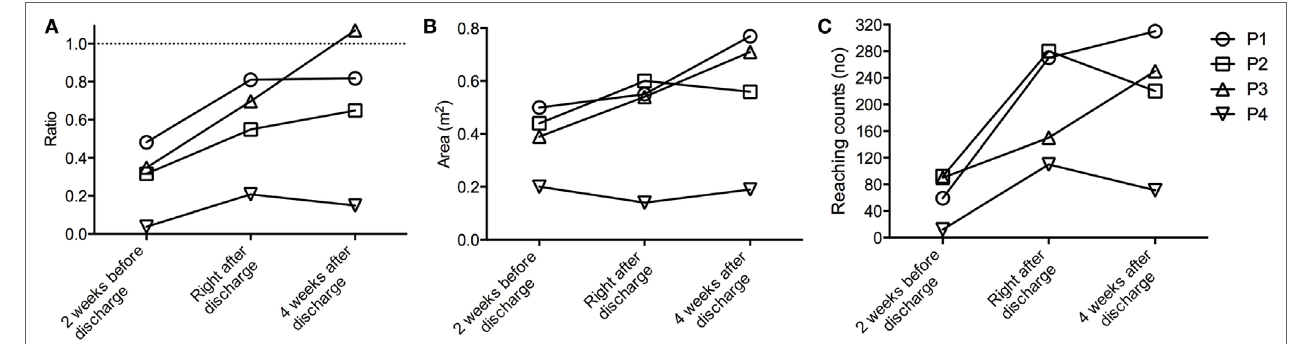
FigUre 3 | Self-directed Activities of Daily Living (sADL). (a) Ratio of reaching counts between non-impaired and the impaired side. (B) Reaching area of the impaired side in the different stages of the rehabilitation. (c) Reaching counts of the affected side for all patients during sADL, measured over time 3